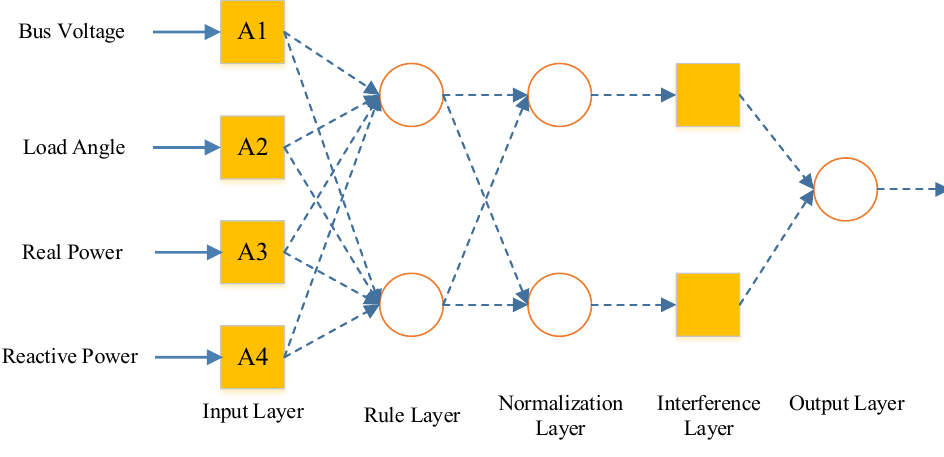
Figure 3. Process of ANSMA model.